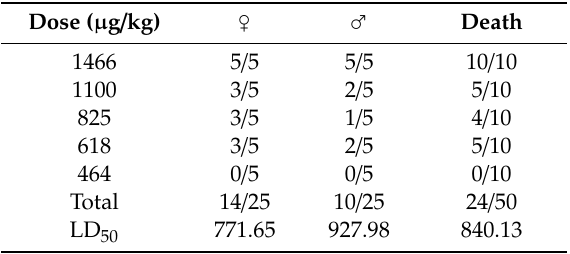
Table 2. The death by a single oral administration of sustained-release TTX pellets on Sprague– Dawley (SD) rats in acute toxicity test.